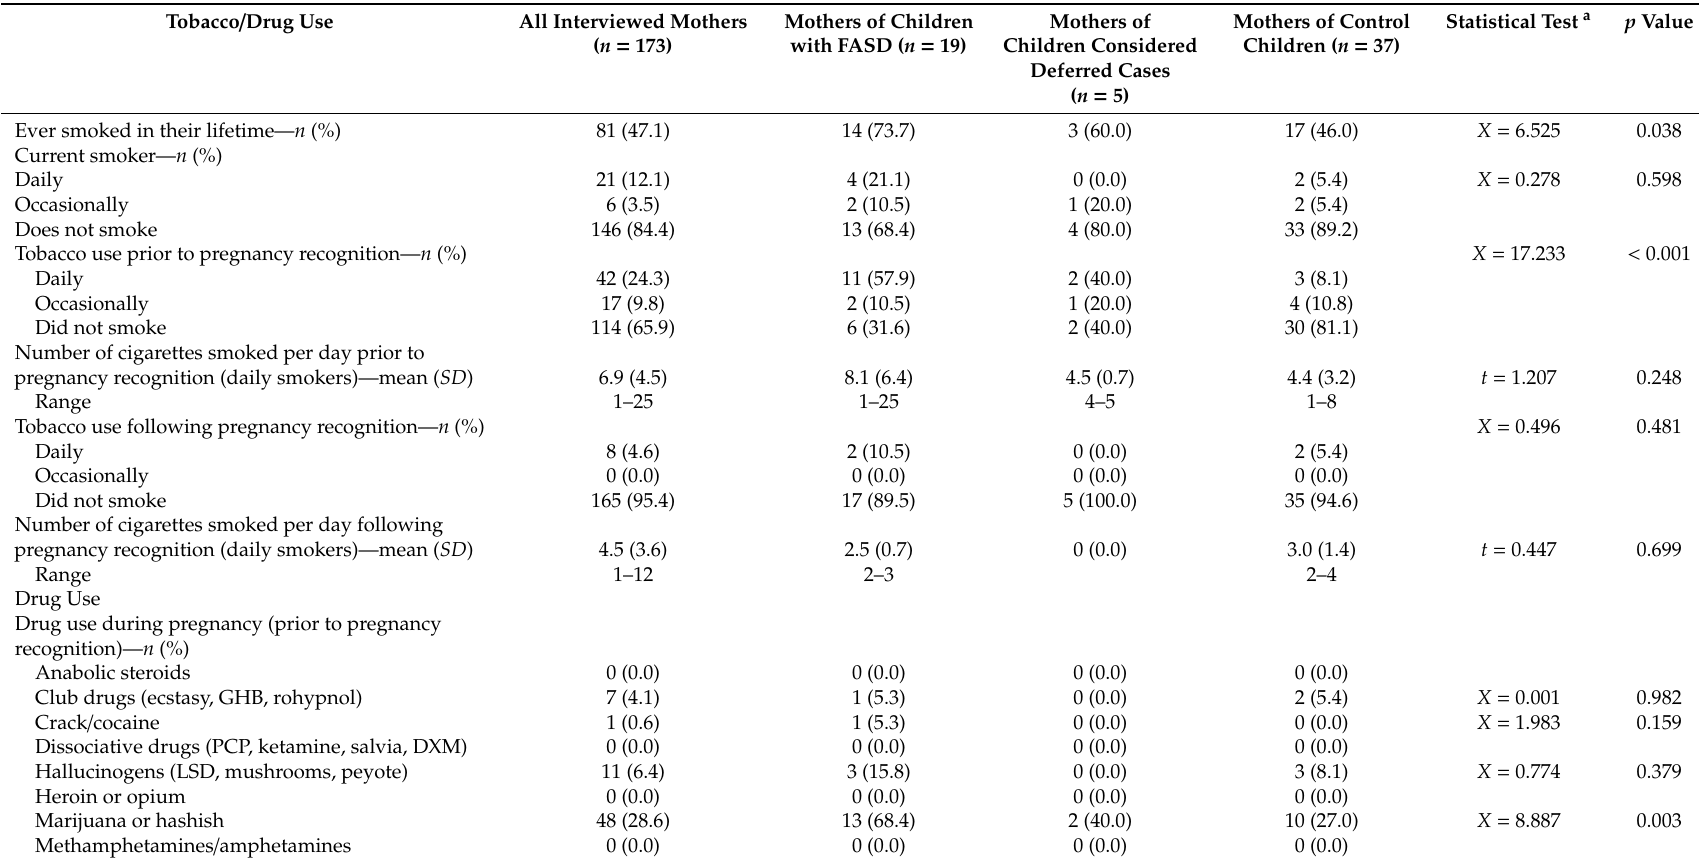
Table 5. Tobacco and drug use during pregnancy among all interviewed mothers, mothers of children with FASD and mothers of control children. Tobacco / Drug Use All Interviewed Mothers ( n =